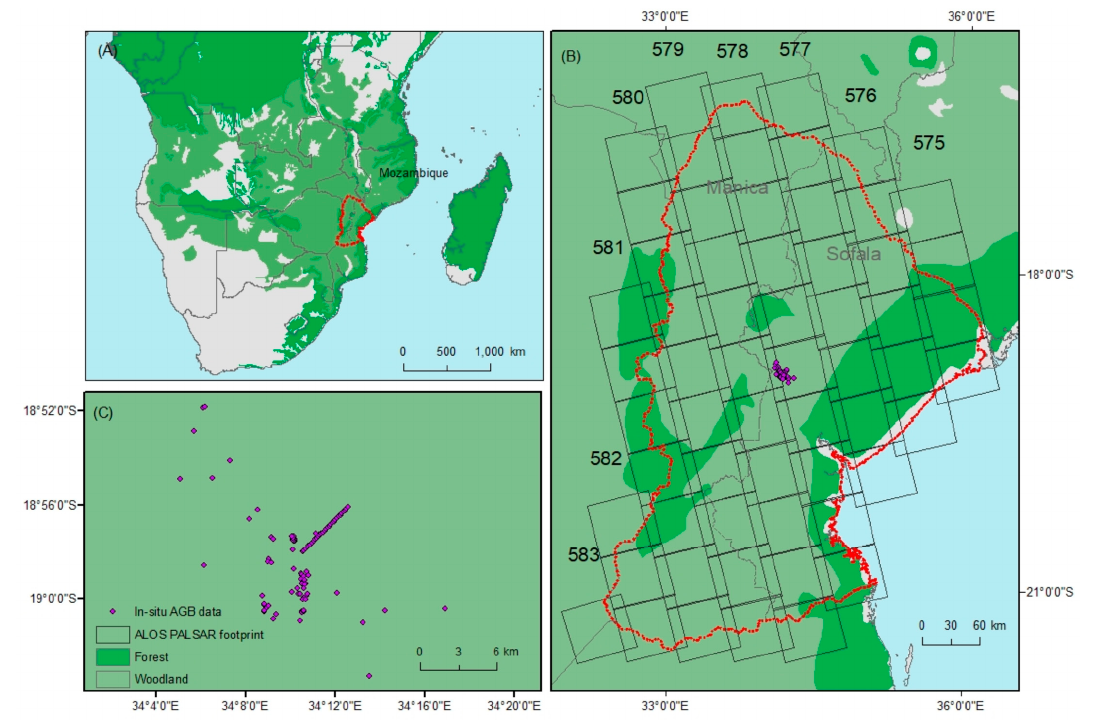
Figure 2. The extent of woodland in Africa ( A ), the study region ( B ), and the distribution of the in situ plots ( C ). ALOS PALSAR-1 footprint and locations of the in situ AGBC plots are also shown in ( B ). Forest and woodlands delineation were adopted from the vegetation map of Africa [40] .